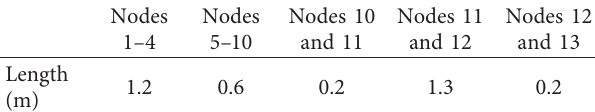
Table 2: The parameters of the shaft.